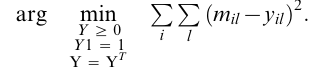
Table S2 Classification of 23 macrophage ligands into 3